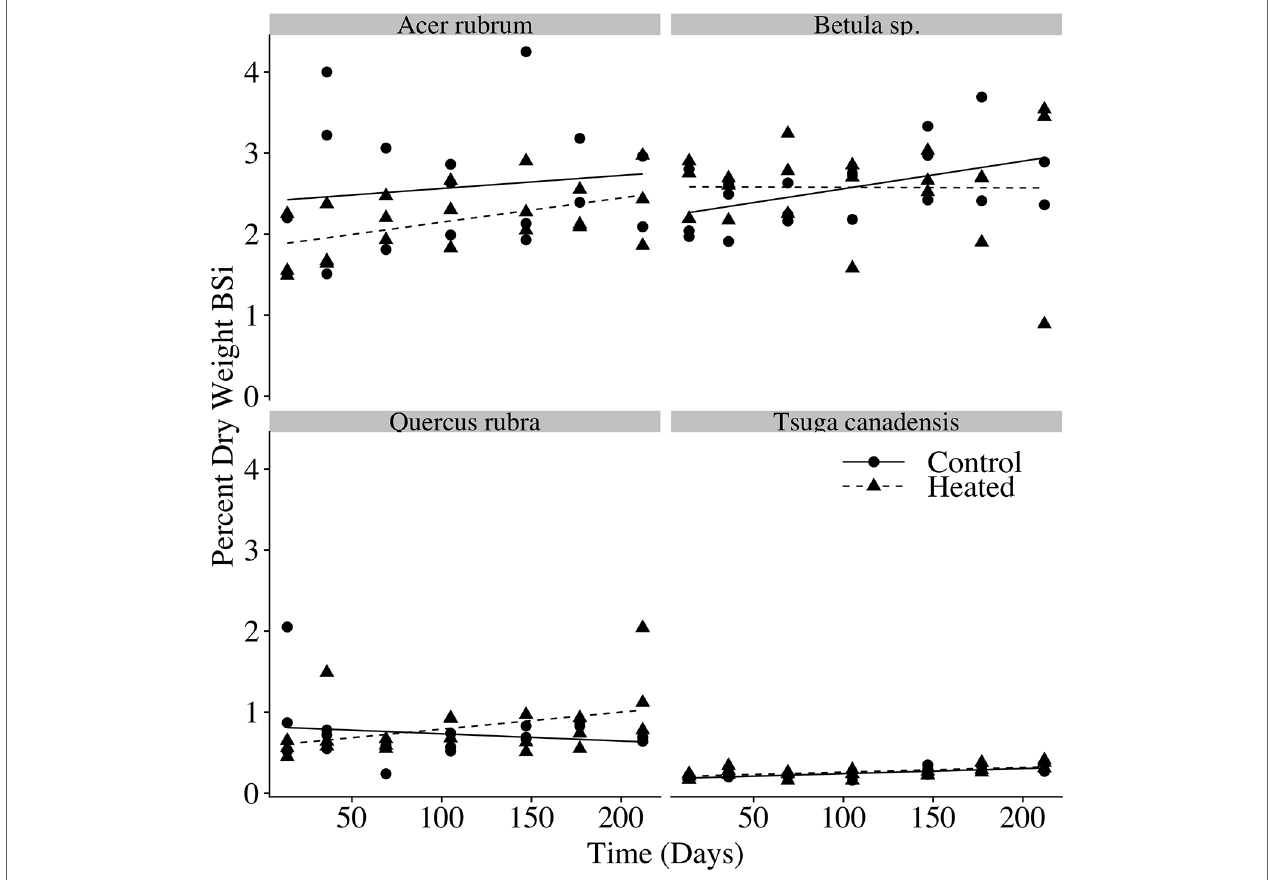
FIGURE 5 | Litterbag BSi concentration over time. Biogenic silica (BSi) concentration (percent dry weight BSi) for each litterbag at time of harvest. Linear regression models are plotted for the control and heated litterbags of each